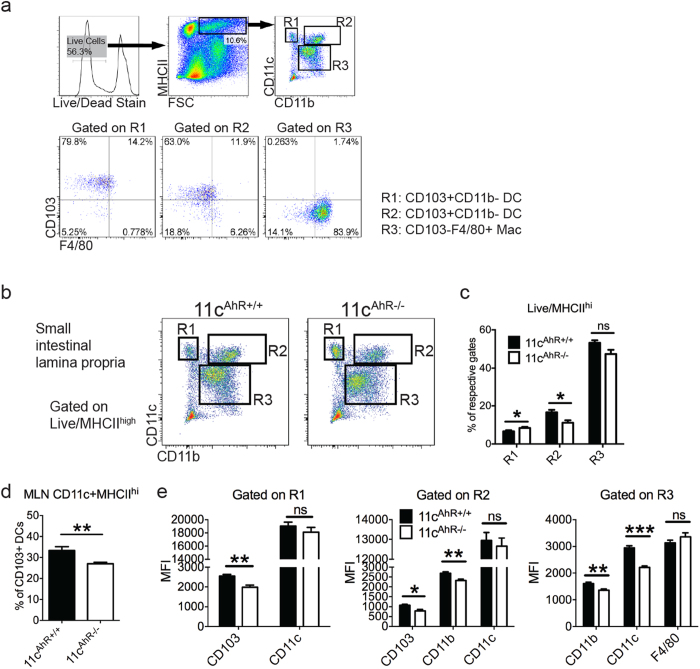
Classical cell-surface markers expressions in intestinal APCs were down regulated in the absence of AhR.(a) Live/MHCIIhi cells were gated and the three major subsets of APCs in the SI LP are presented as shown based on their expression of markers: CD11c, CD11b, CD103 and F4/80. (b–c) Quantification of the three major subsets of APCs as defined in (b), shown as percentages among total live/MHCIIhi cells. Results are mean ± SEM pooled from 5 independent experiments (n ≥ 10). (d) Quantification of MLN CD103+ DCs as mean percentages ± SEM is shown (n = 6). (e) Mean fluorescent intensity (MFI) representing expression levels of various cell surface markers of gated populations of all three groups are shown. Data are mean ± SEM pooled from 4–5 independent experiments (n ≥ 9). Mann-Whitney test: *P < 0.05; **P < 0.01; ***P < 0.001; ns, not significant.